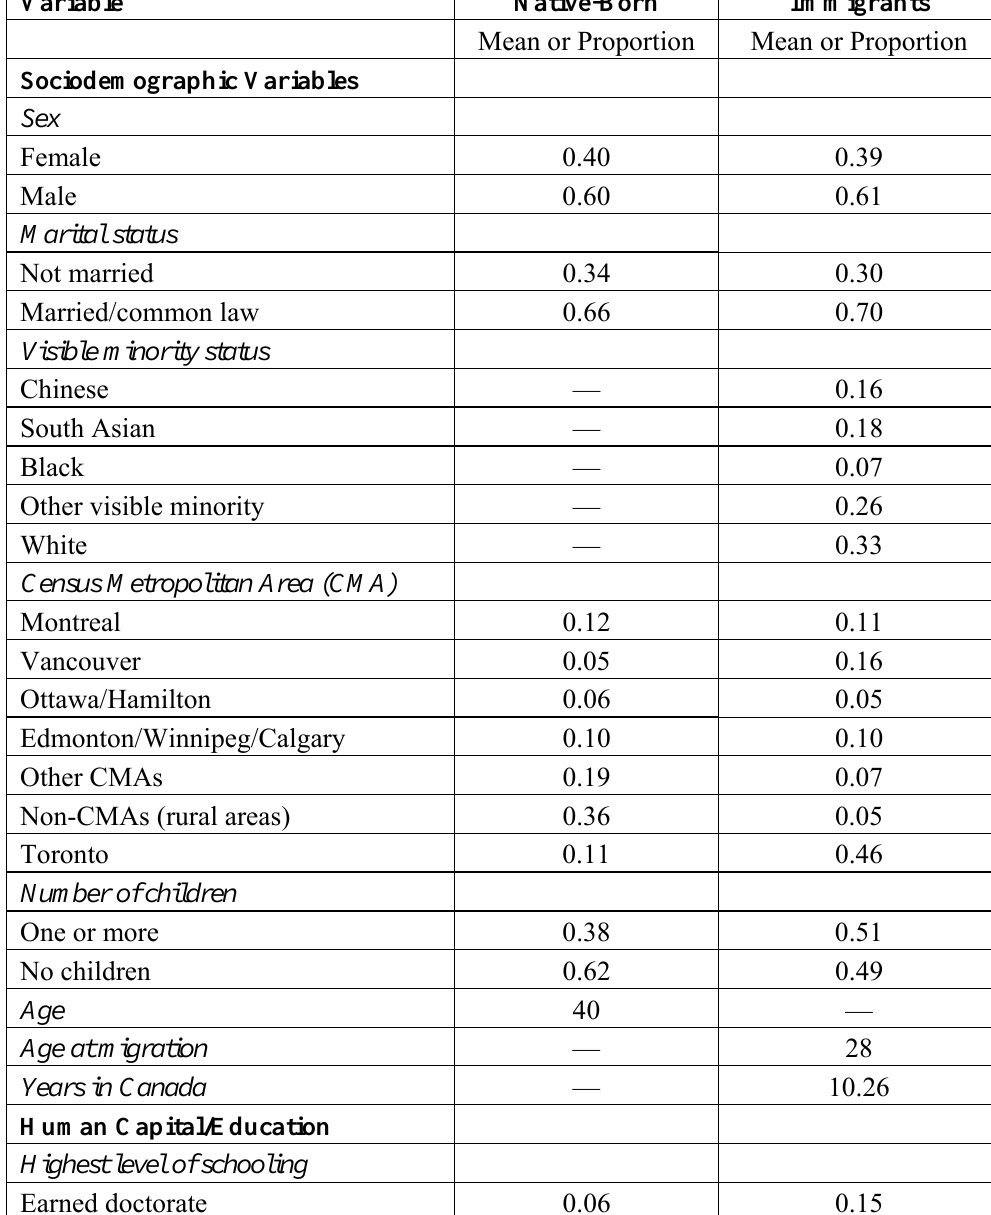
Table 1. Descriptive statistics for variables in the study, by immigrant